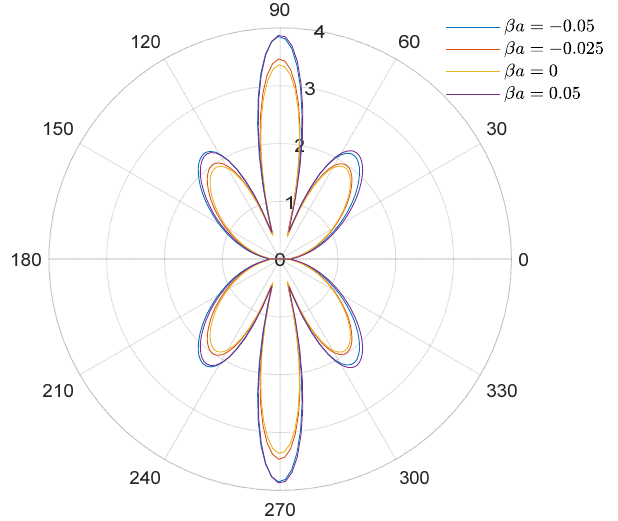
Figure 2. Polar graph of DSCC around the elliptical opening with ka = 0.1 and m = 1/6.